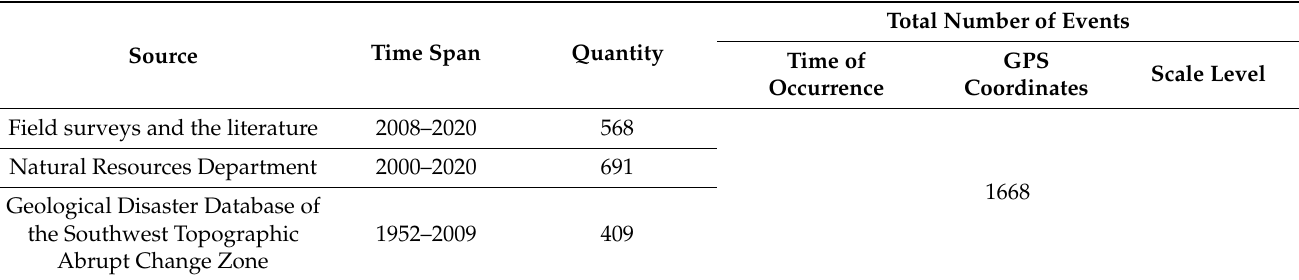
Table 1. Data sources of the debris flow